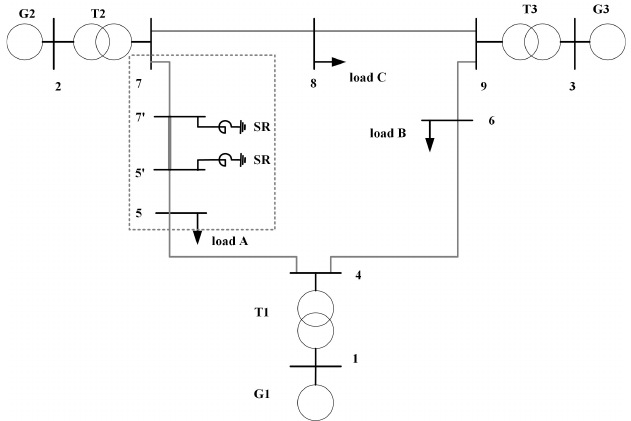
Figure 3. Single line diagram of a WSCC 3-machine 9-bus test system with a mixed line: a cable of 40 km is inserted in line 7-5, with two shunt reactors of 2x100 MVAR ratings to compensate the reactive power requested by the